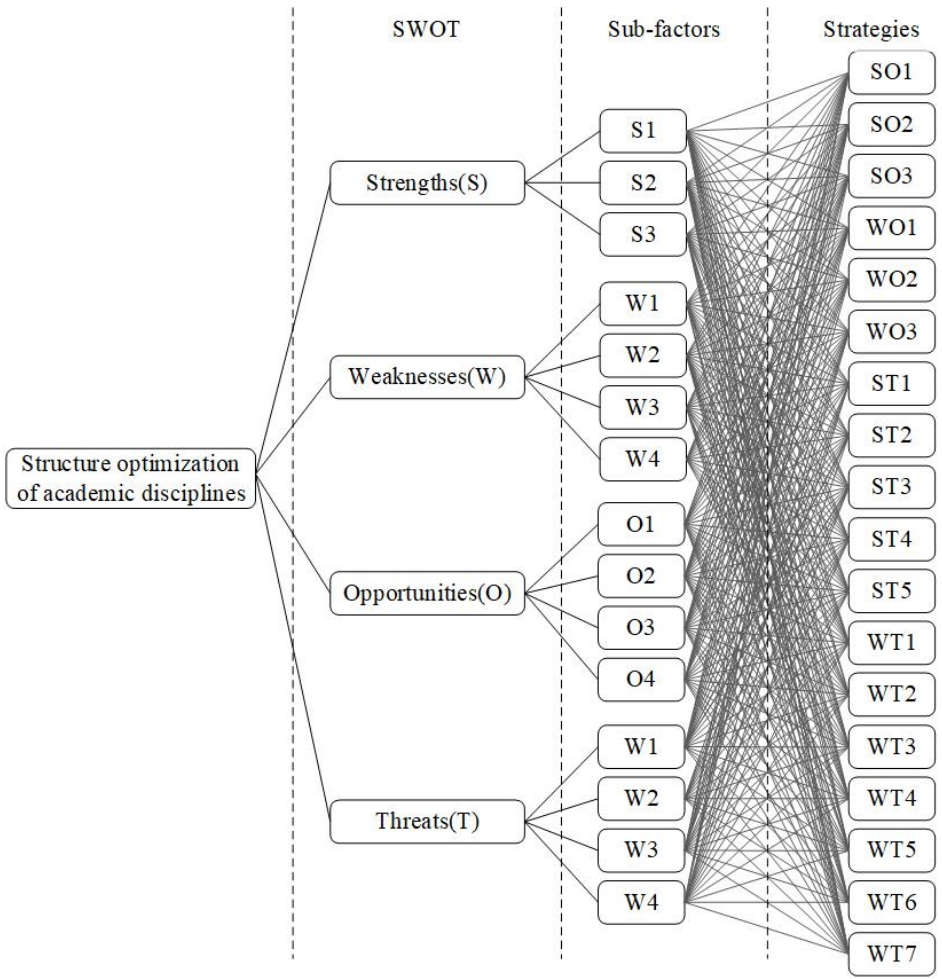
Figure 3. The hierarchy and network structure.